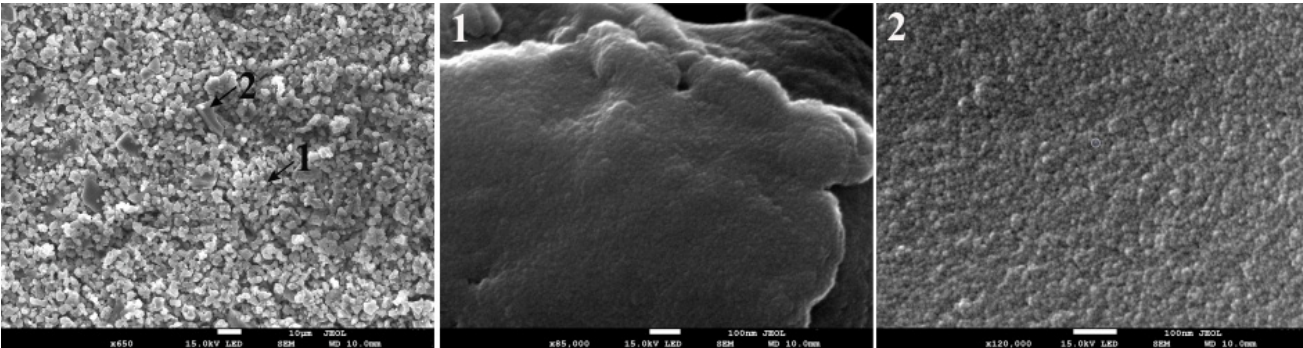
Figure 11. SEM images of the char produced at 603 K and 10 min residence time. High magnification images of the regions marked as 1 and 2 are displayed in the middle and the right panel respectively.